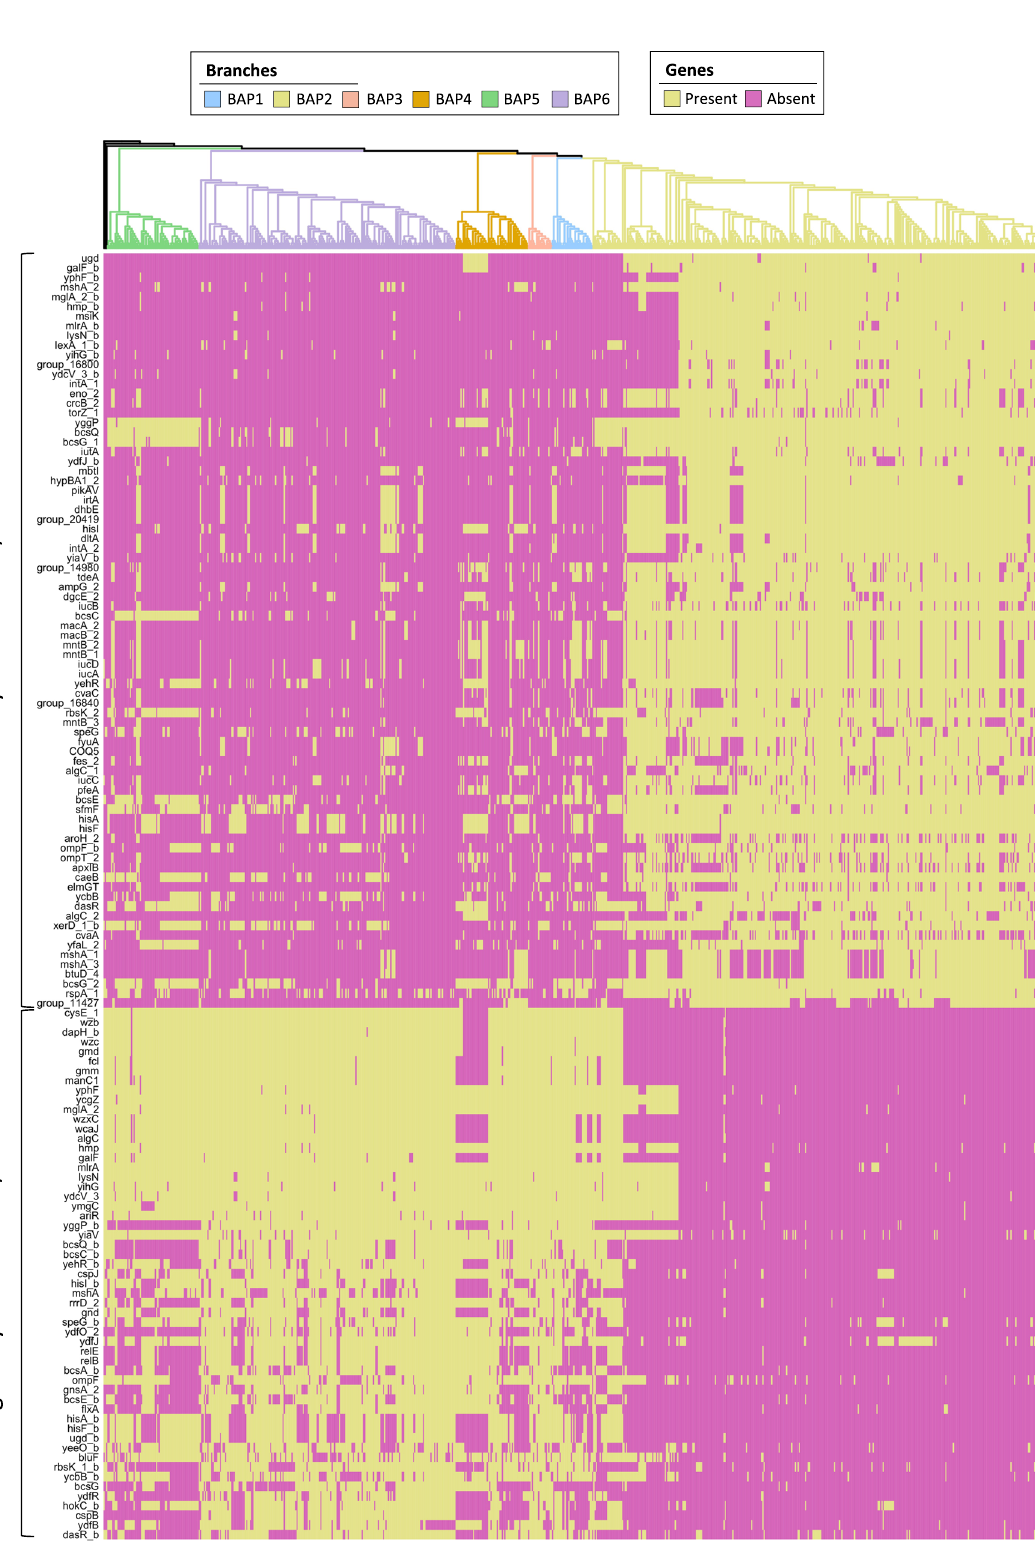
Fig. 6 Genes associated with the BAP2 cluster. Presence/absence (yellow/magenta) of genes positively and negatively associated with the BAP2 cluster mapped to the phylogeny. Tree branches indicate BAP compared human source sequences (ExPEC, other) with pairwise occurred between 26 humans (15 ExPEC, 11 other) sequences SNP counts of 20 or less to sequences from the remaining and 34 non-human sequences representing 11 of the 13 non- 13 source categories. For perspective, 20 SNPs across the 2.8Mbp human sources (Fig. 9). This analysis revealed a close linkage core gene alignment constitutes a core nucleotide divergence of between geographically and temporally distinct strains. One just 0.0007%. We identi fi ed 135 pairwise cases of ≤ 20 SNPs that cluster comprised 8 ExPEC from Denmark and 3 human others